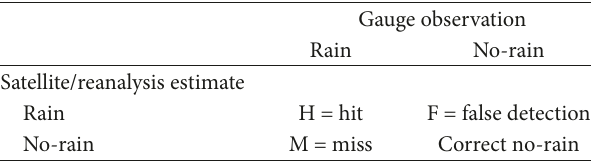
Table 2: A 2 × 2 contingency